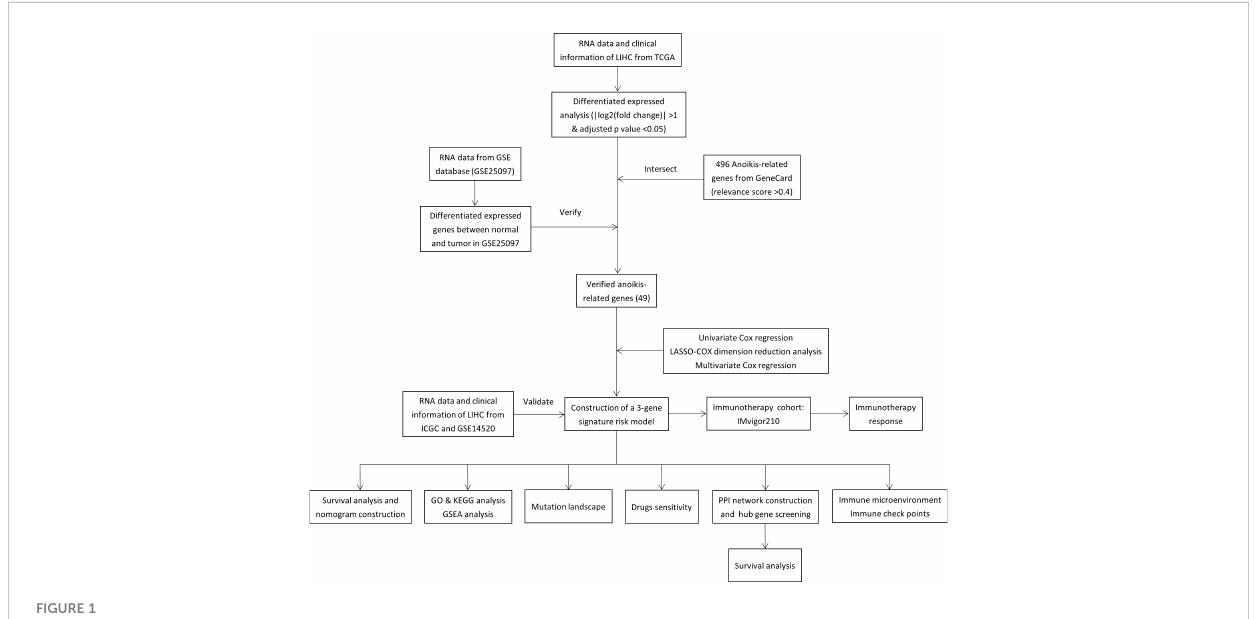
FIGURE 1 Flow chart of the